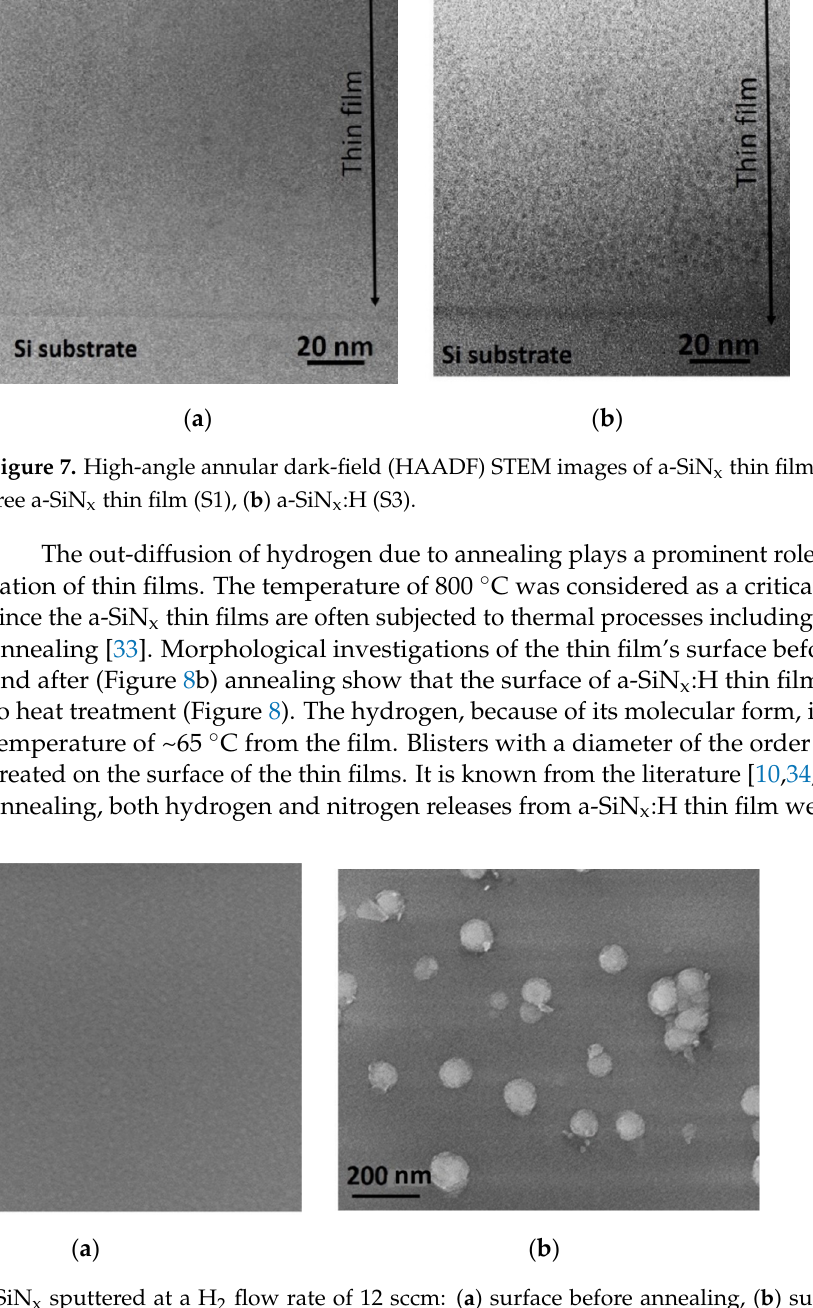
Figure 7. High-angle annular dark-field (HAADF) STEM images of a-SiN x thin films: ( a ) hydrogen-free a-SiN x thin film (S1), ( b ) a-SiN x :H (S3).